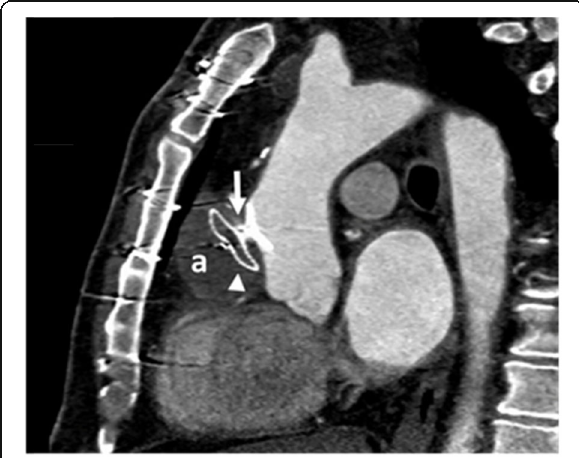
Fig. 8 Electrocardiogram-gated CT angiography in the oblique sagittal plane in the same patient, one months after successful device closure demonstrates complete thrombosis of the pseudoaneurysm sac. A completely thrombosed pseudoaneurysm sac. Arrow head: device arrow: completely occluded pseudoaneurysm